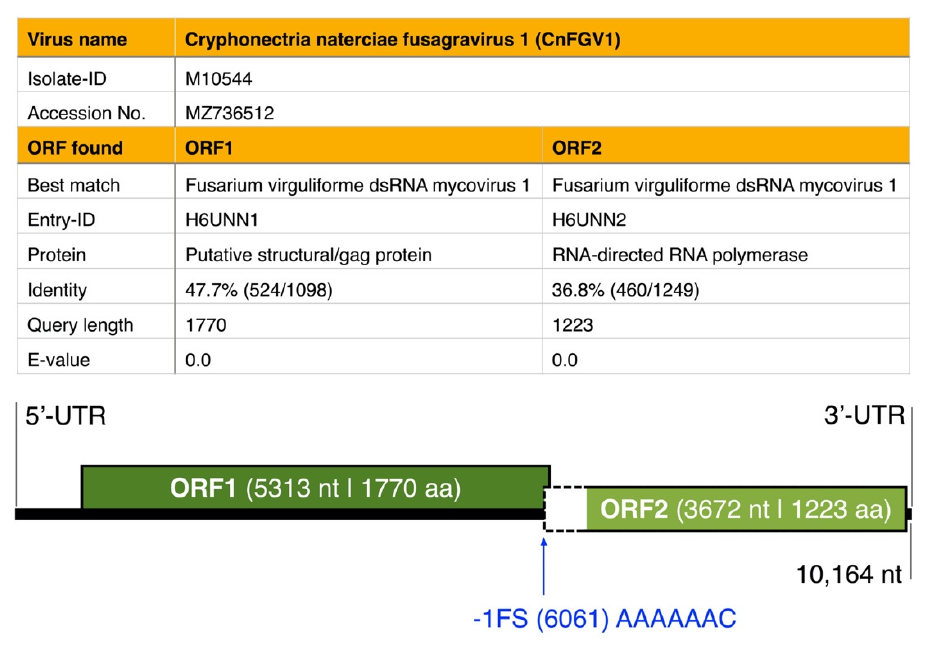
Figure 2. Characterization of dsRNA extracted from Cryphonectria naterciae . ( A ) Agarose gel electrophoresis of dsRNA used for RNA-seq before (left) and after (right) DNase and S1 nuclease treatment. ZR1: 10, 5, 3 kb; ZR2: 20, 7, 4, 2.5 kb, Thermo Scientific ZipRuler Express DNA Ladder Set (SM1373). ( B ) Unrooted neighbor joining tree of a 958 nt alignment including concatenated sequences of ORF1 and ORF2. Bold labels highlight strains associated with C. naterciae from Quercus suber ; others are from Castanea sativa . Numbers represent bootstrapping rate of 1000 replicates.